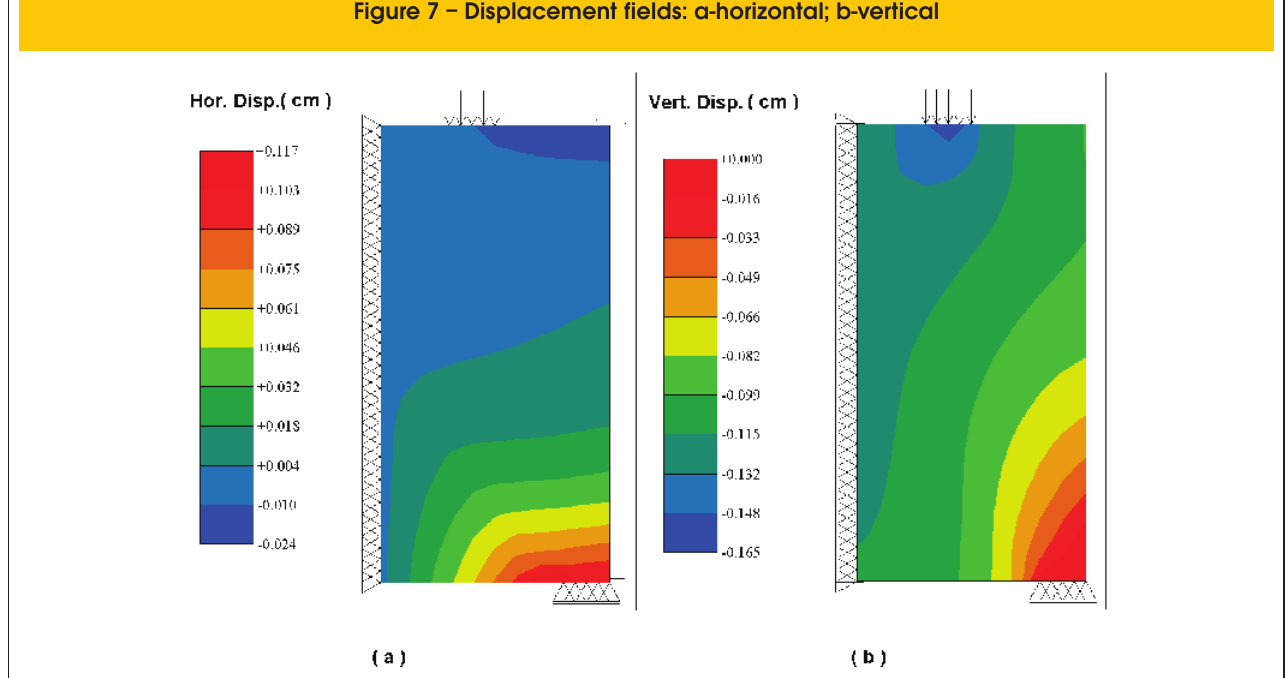
Figure 7 – Displacement fields: a-horizontal;